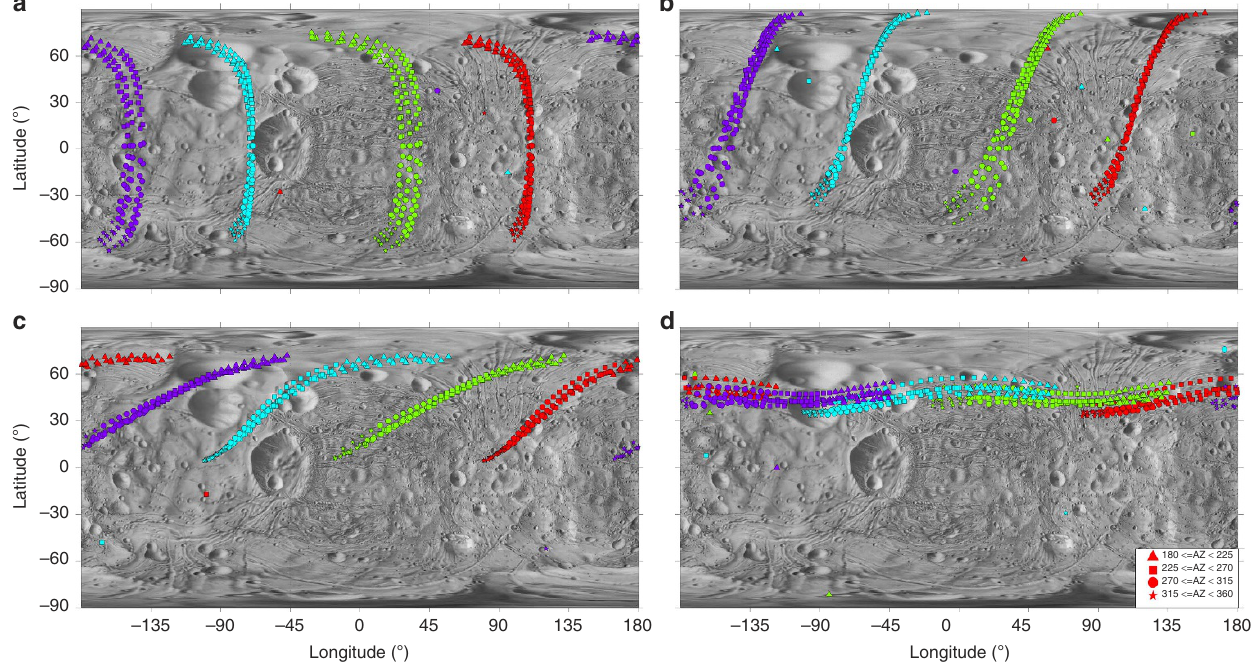
Figure 5 | Catenae orientations change from vertical to horizontal depending on the latitude of the primary impact. Maps show resultant catenae from primary impacts on Phobos at the prime meridian and ( a ) 0 (cid:2) N, ( b ) 30 (cid:2) N, ( c ) 60 (cid:2) N and ( d ) 85 (cid:2) N. Resulting orientations are the mirror inverse of those from impacts to the Southern Hemisphere (compare with Supplementary Fig. 5). Variations with orbital geometry at primary impact can be seen, namely, when Phobos is at Mars periapsis (red), apoapsis (blue), halfway between periapsis and apoapsis along the ascending node (purple) and descending node (green). Ejection velocities are 11–30ms (cid:3) 1 ; the source crater is 3km in diameter. Shapes denote ejection azimuth (legend); azimuths b A [ p : p /36:2 p ] are shown (compare with Supplementary Fig. 4).